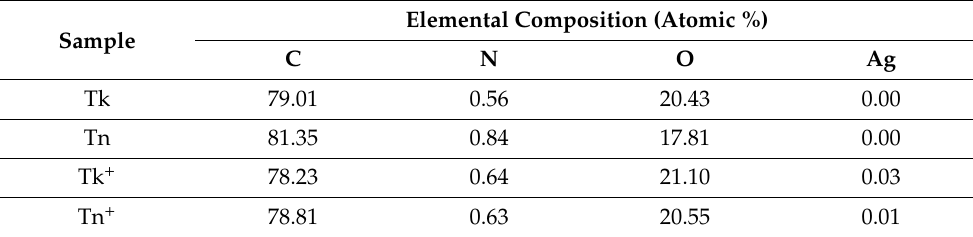
Figure 4. The X-ray photoelectron spectroscopy (XPS) analysis of Tk, Tn, Tk + , and Tn + CSNFMs ( A ) and high resolution XPS spectra of Tk + , and Tn + CSNFMs ( B ). Table 1. The elemental composition from X-ray photoelectron spectroscopy (XPS) analysis.